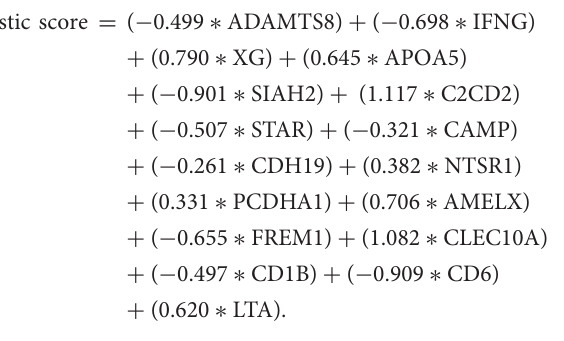
algorithm ( Figure 8A ), multitask logistic regression algorithm ( Figure 8B ), and Cox survival regression algorithm ( Figure 8C